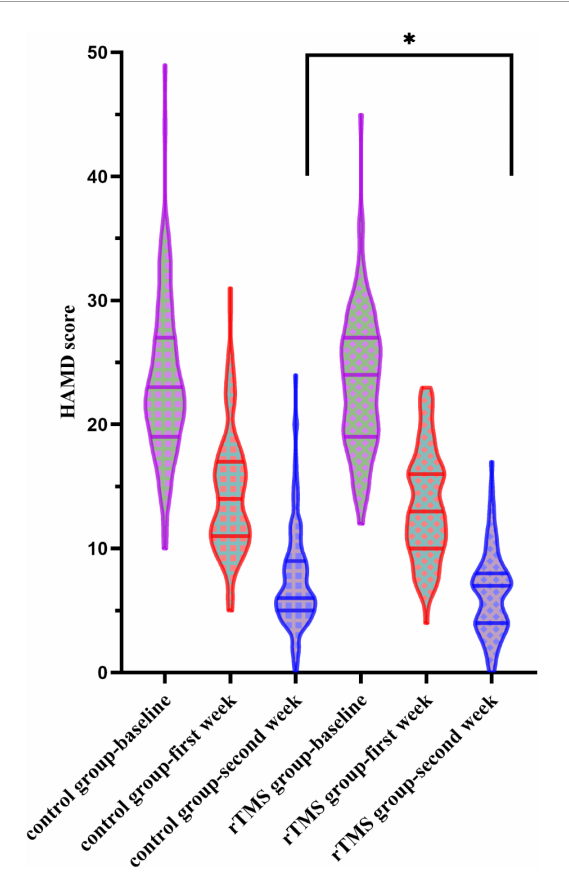
FIGURE2 Hamilton Rating Scale for Depression (HAMD) scores at the baseline, the first week, and the second week in the control and the repetitive transcranial magnetic stimulation (rTMS) group. *Indicates a significant difference at the p = 0.05 level.